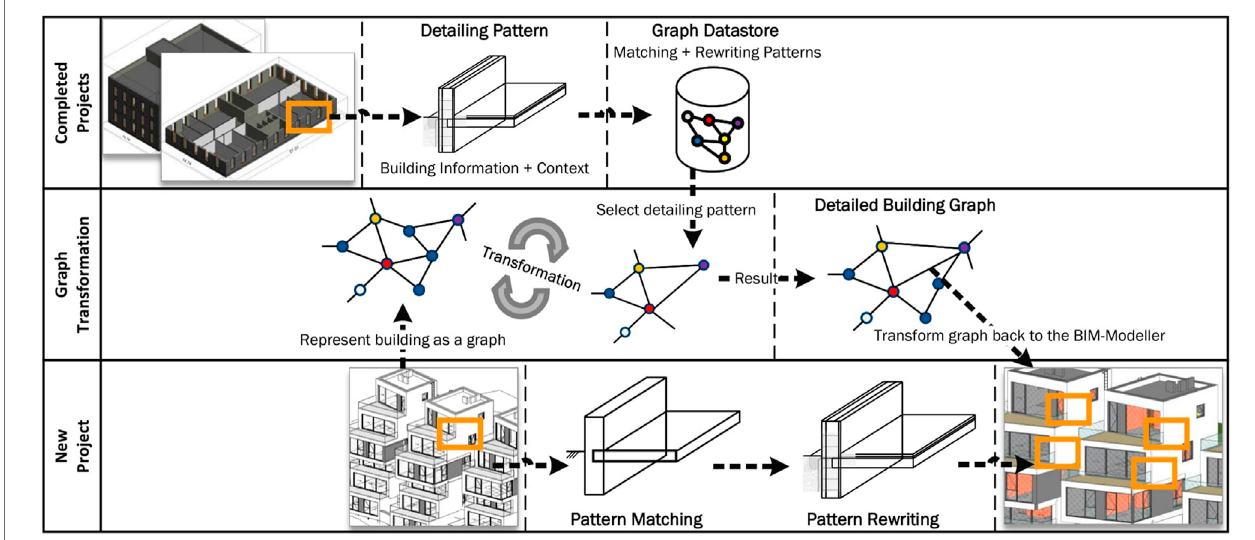
FIGURE 15 | Worfklow proposing a user-oriented interface to formalize architectural design patterns without knowledge of underlying representation and algorithms (Abualdenien and Borrmann, 2021).